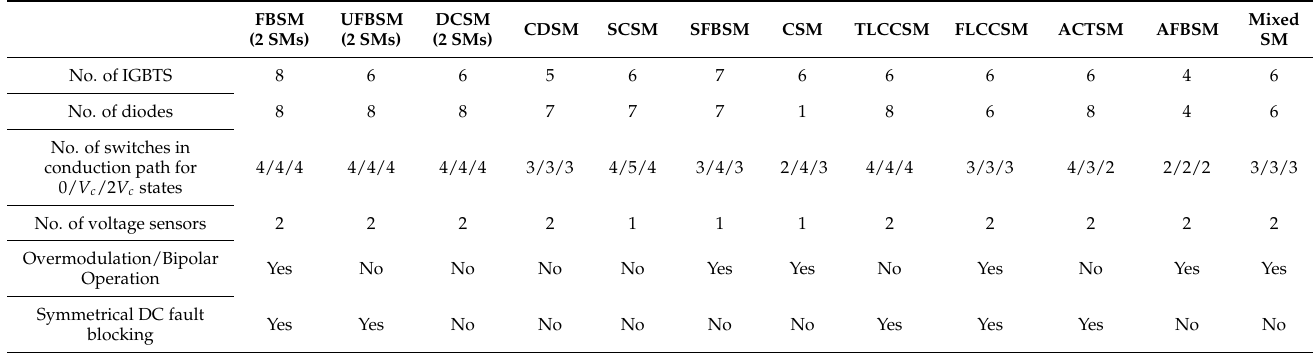
Table 3. Comparison among different fault blocking